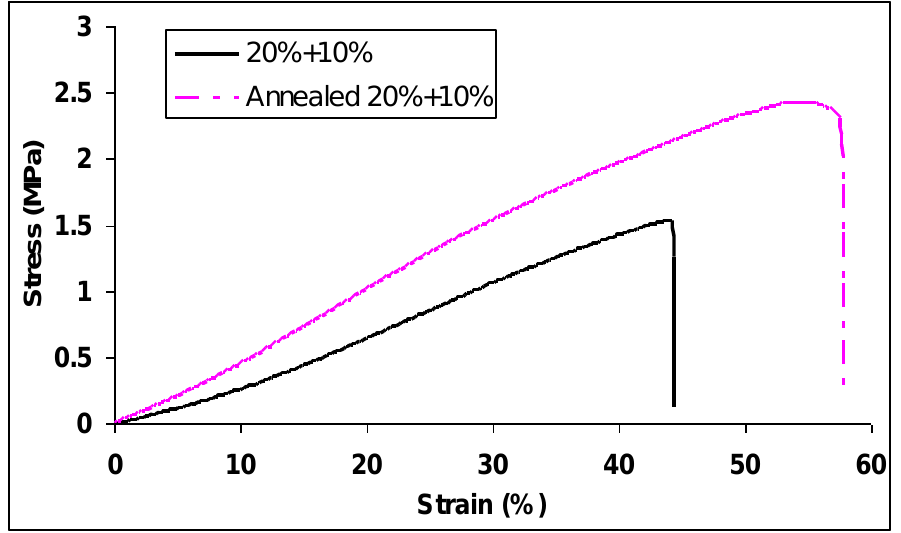
Figure 4. Typical stress-strain plots of nylon 6 non-woven fiber mats electrospun from 20 wt % and 10 wt % solutions before and after annealing at 70 °C for 24 h. Table 2. Tensile properties of nylon 6 non-woven fiber mats electrospun from 20 wt % and 10 wt % solutions before and after annealing at 70 °C for 24 h .